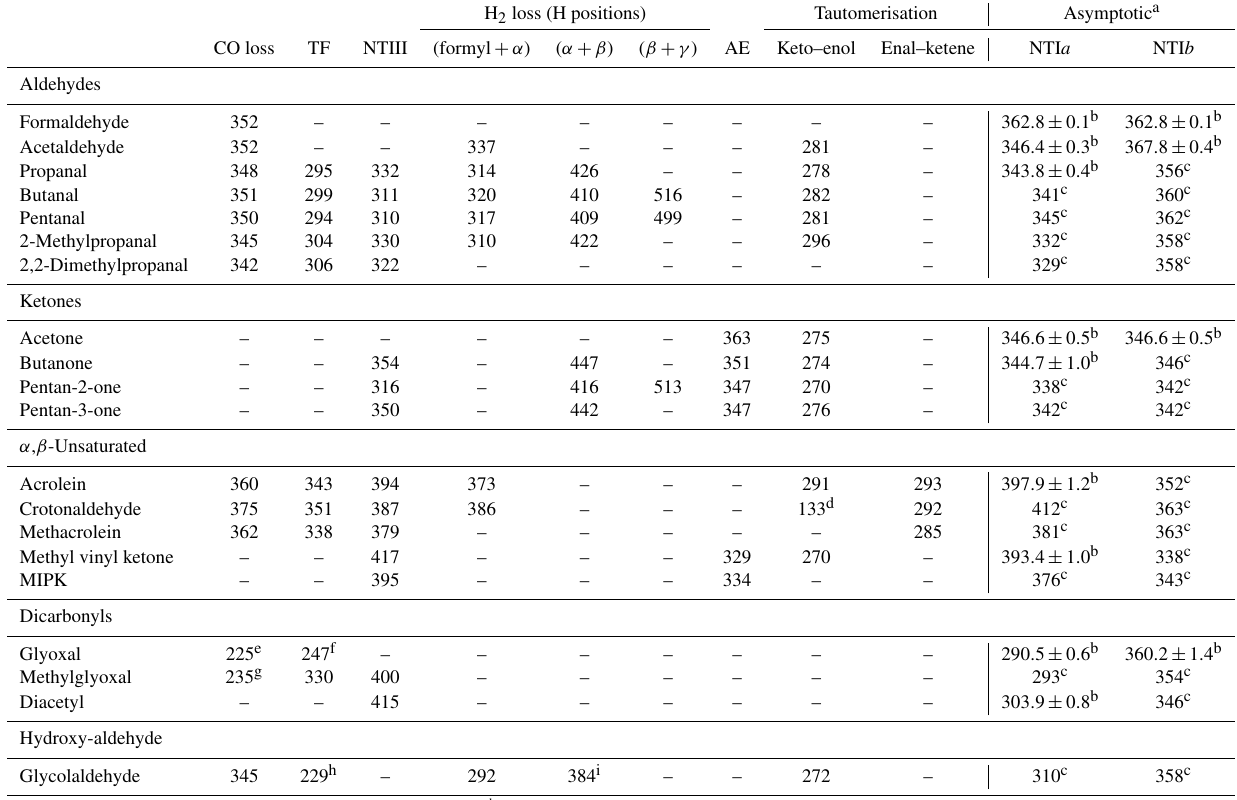
Table 1. Lowest energy zero-point vibrational-energy-corrected B2GP-PLYP-D3/def2-TZVP S 0 thresholds (kJ/mol) for the indicated uni- molecular reactions of the carbonyls in the test set (see